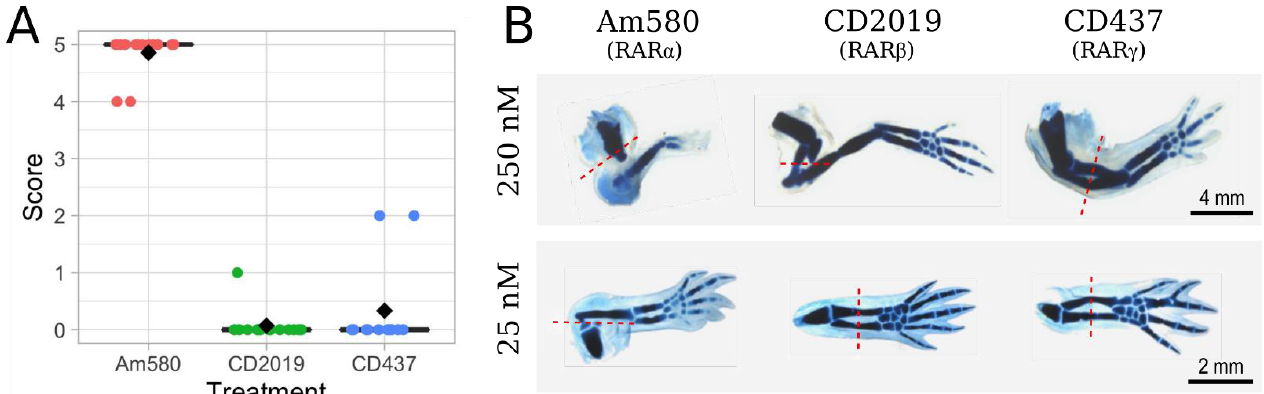
Figure 4. Comparison of PD limb duplication at 250 nM and 25 nM systemic agonist treatment. ( A ) Scoring following Victoria blue staining of mid-zeugopod limb regenerates treated with 25 nM agonist reveals a decrease in duplication to nearly zero in both CD2019 ( n = 14 limbs; p = 9.4 × 10 − 10 ) and CD437 ( n = 12; p = 5.1 × 10 − 4 ). There is no significant difference between Am580 ( n = 14) treatments at 250 nM (Figure 3) and 25 nM ( p = 0.082); ( B ) Representative limb regenerates following systemic exposure to 250 nM (upper panel) or 25 nM RAR (lower panel) agonists. The amputation plane is shown in red. The photos were processed by removing the background and adjusting the